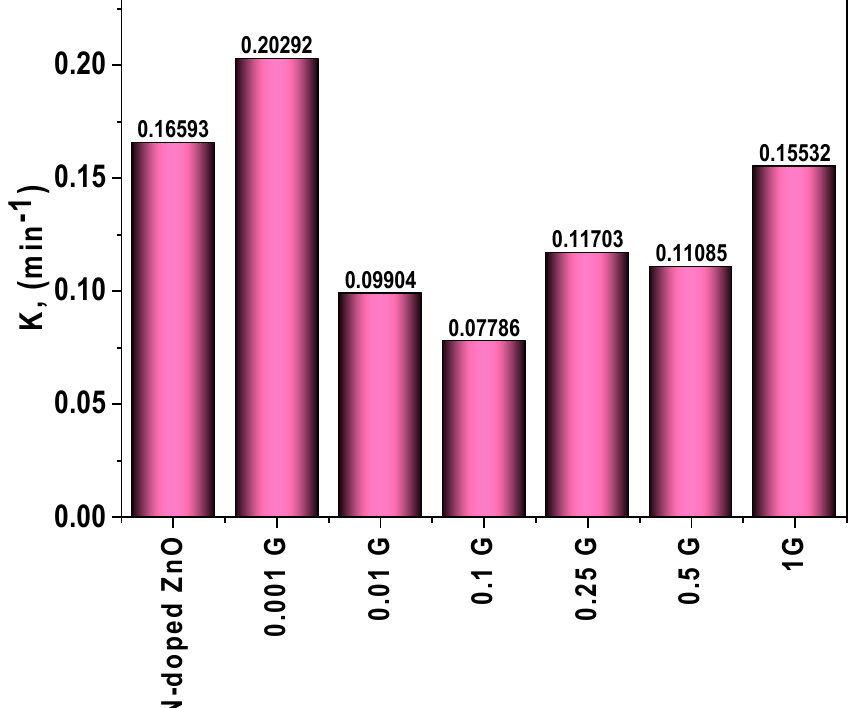
Figure 9. Rate constant values of carmine dye in the presence of N-doped ZnO and G/N-doped ZnO with different concentrations of graphene after an interval time of 15 min using the indirect electrochemical degradation method.